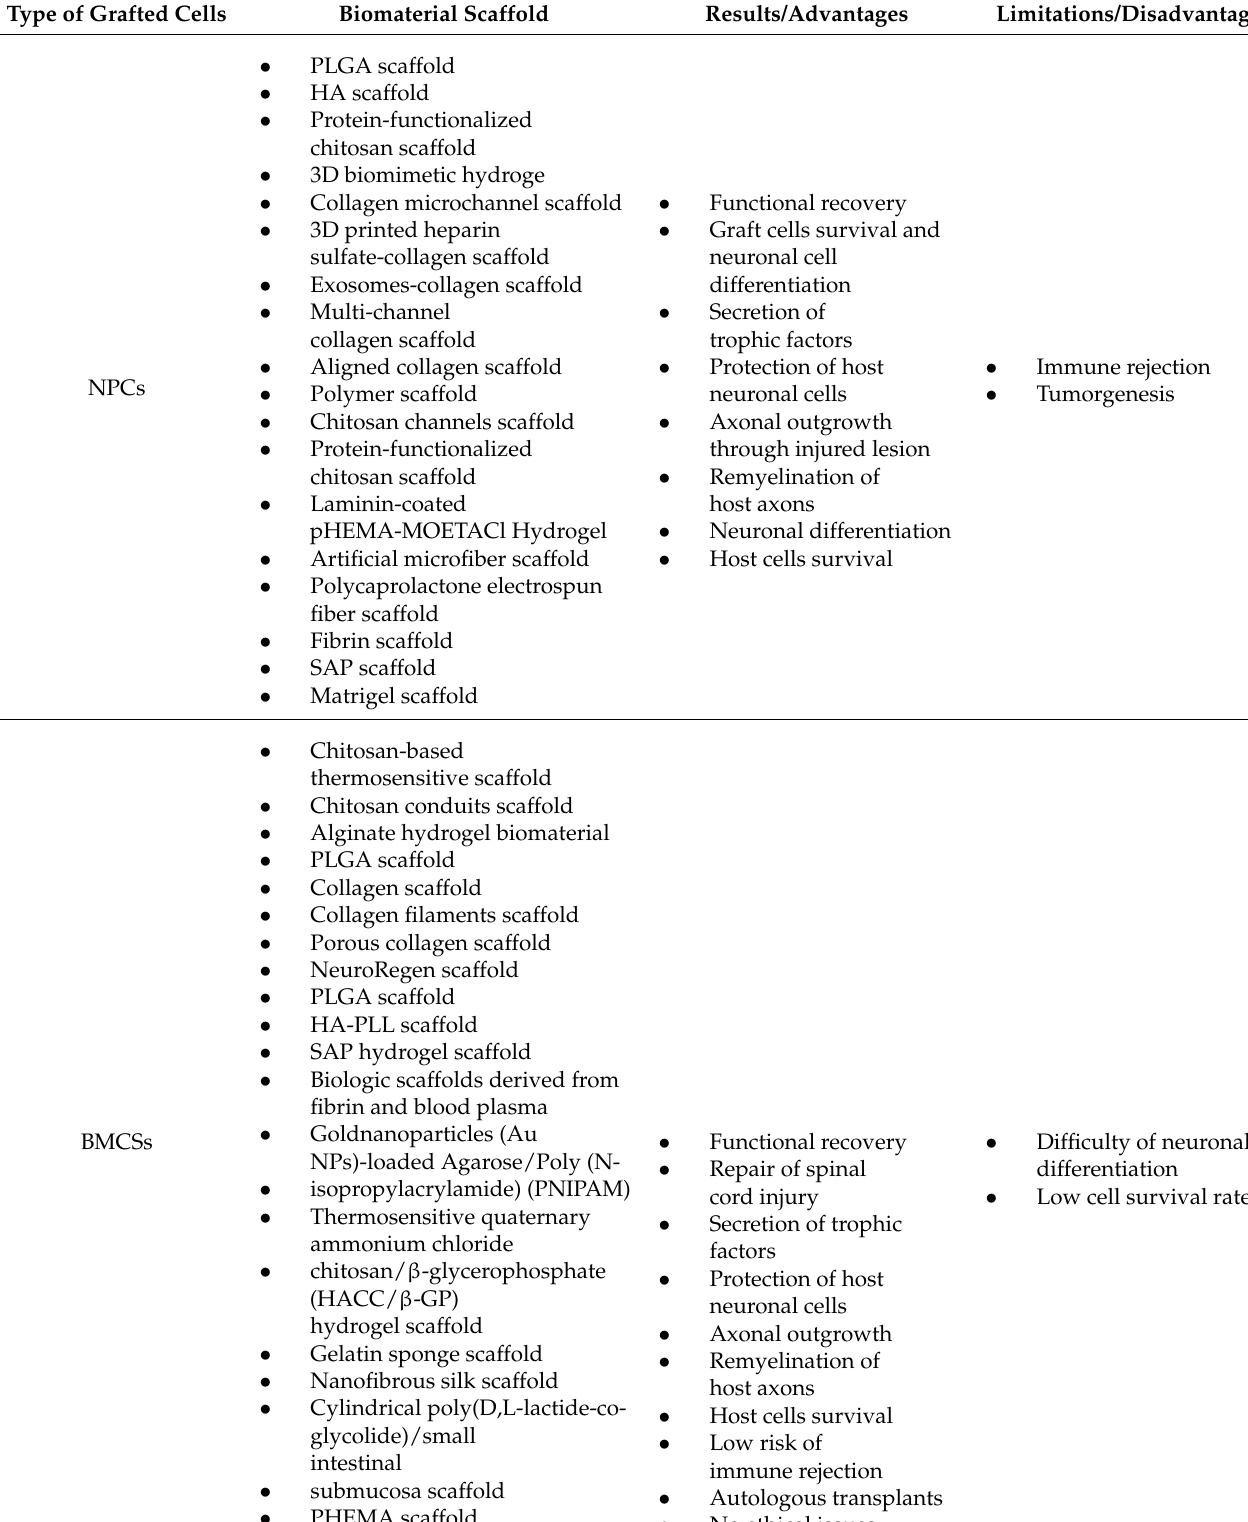
Table 5. Summary of the included studies and the effect of combinatory cell therapy for SCI. Type of Grafted Cells Biomaterial Scaffold